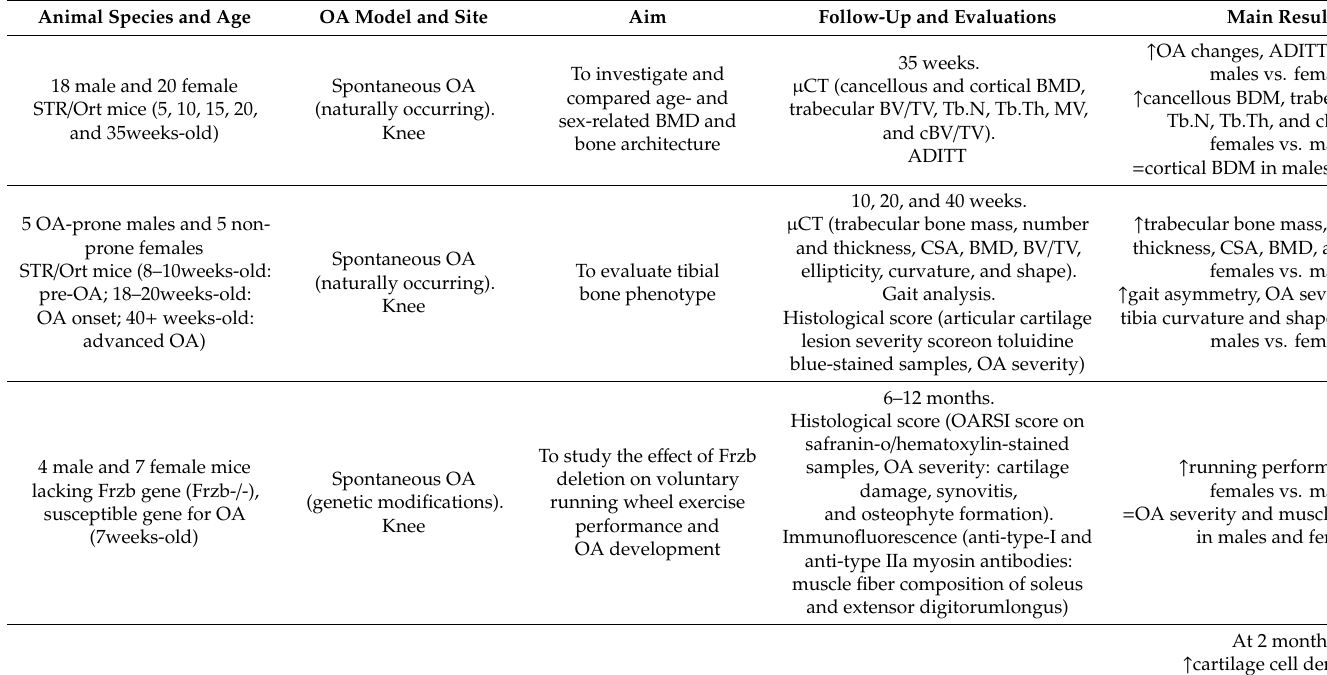
Table 2. Summary of the preclinical in vivo